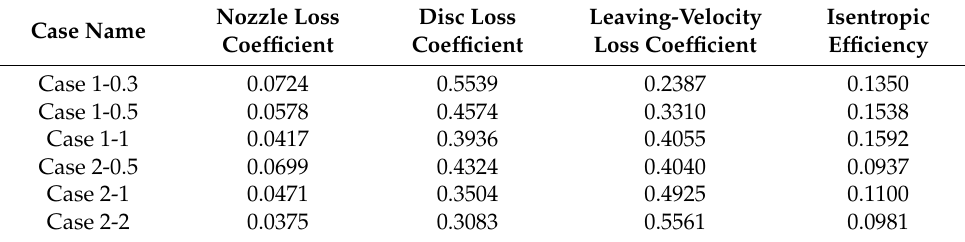
Table 6. Coefficients of component energy loss for one-to-many Tesla turbine